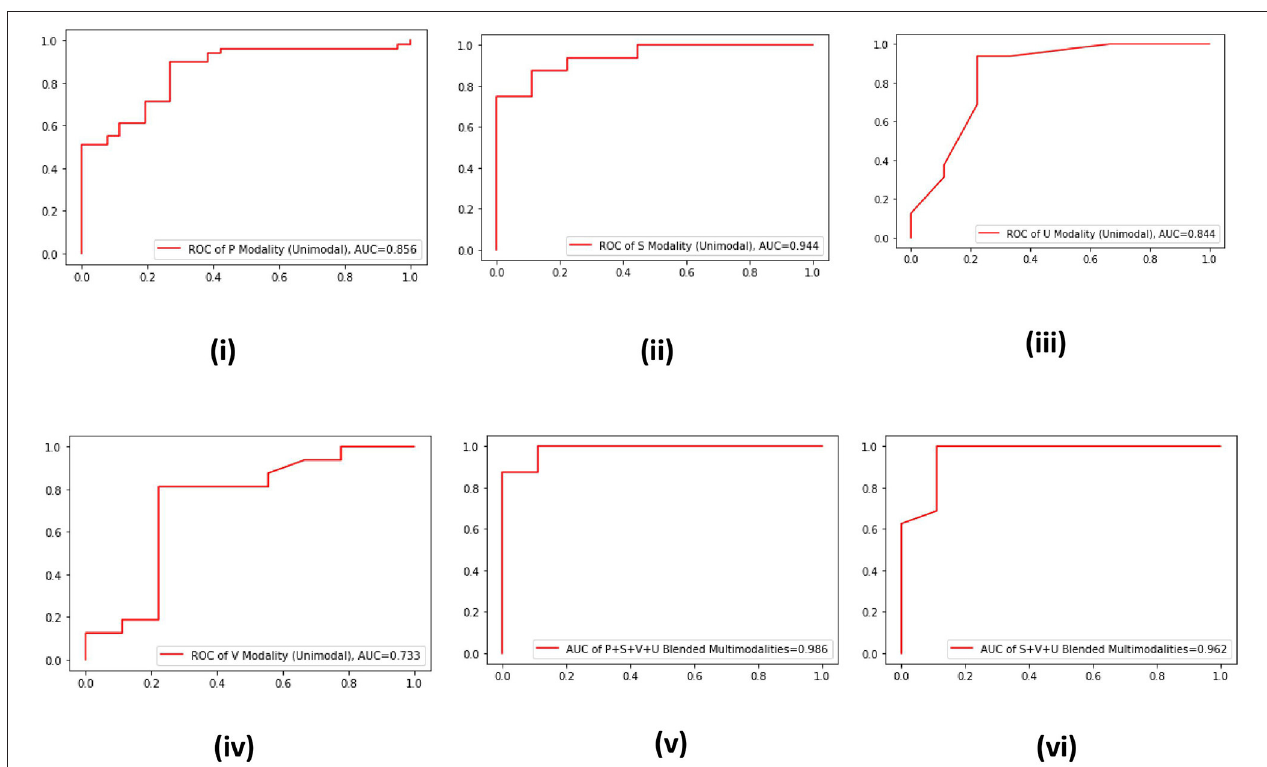
FIGURE 3 | (i–vi) ROC curves of four unimodal13 SP channel data-driven systems and two multimodal data–driven blended systems.